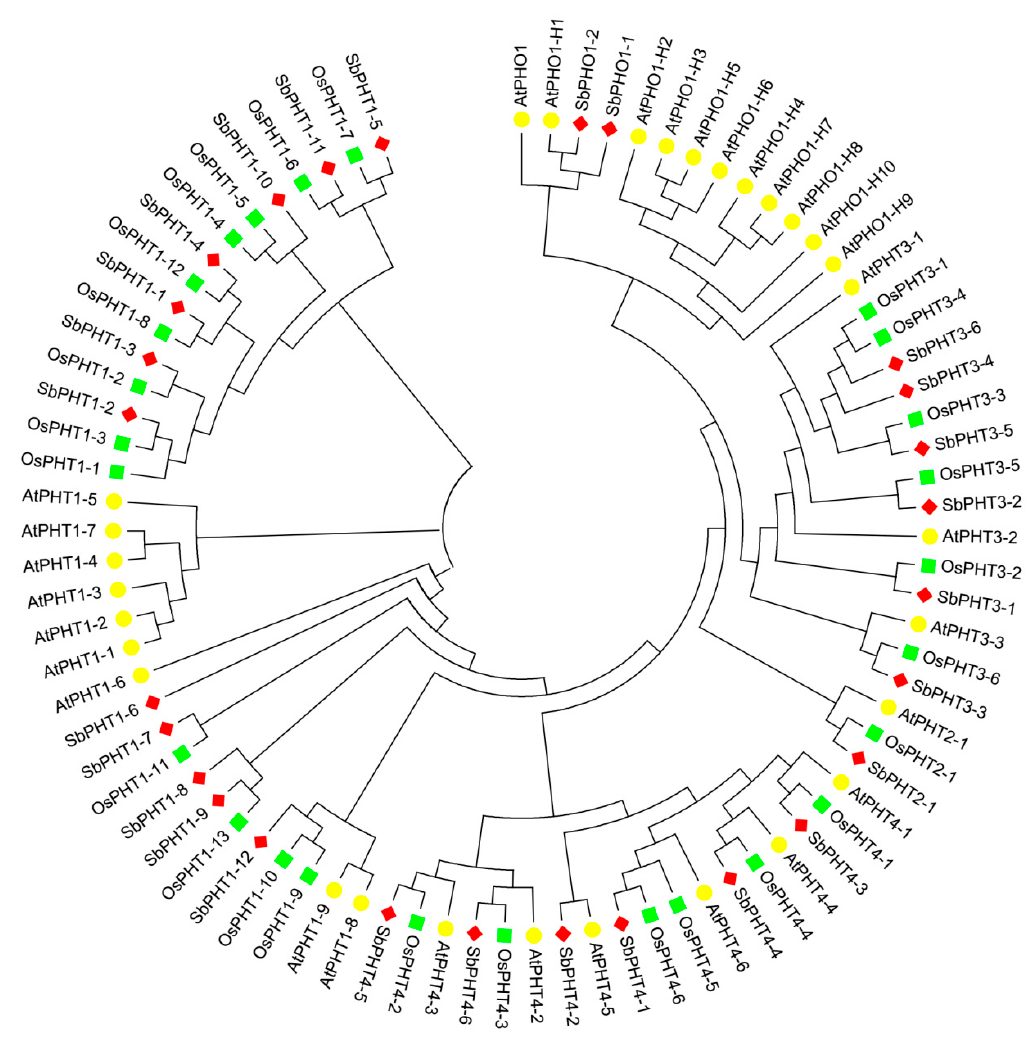
Figure 1. Phylogenetic tree of PHT proteins from Sorghum , Arabidopsis , and rice. The unrooted neighbor joining (NJ) phylogenetic tree was constructed by using the full-length sequences of PHT proteins from Sorghum , Arabidopsis , and rice. The red diamond, yellow circle, and green square represent PHT proteins from Sorghum , Arabidopsis , and rice, respectively.